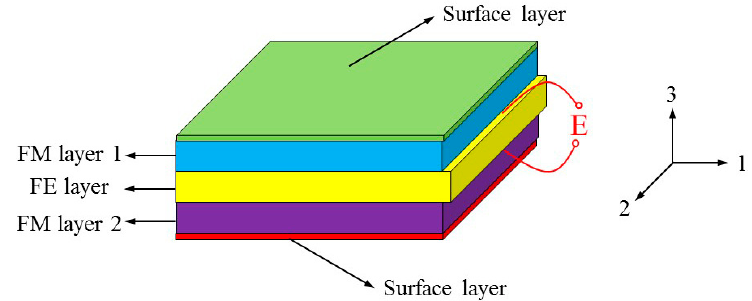
Figure 1. Schematic sketch of multiferroic nanocomposites consisting of ferroelectric (FE) material and different ferromagnetic (FM)